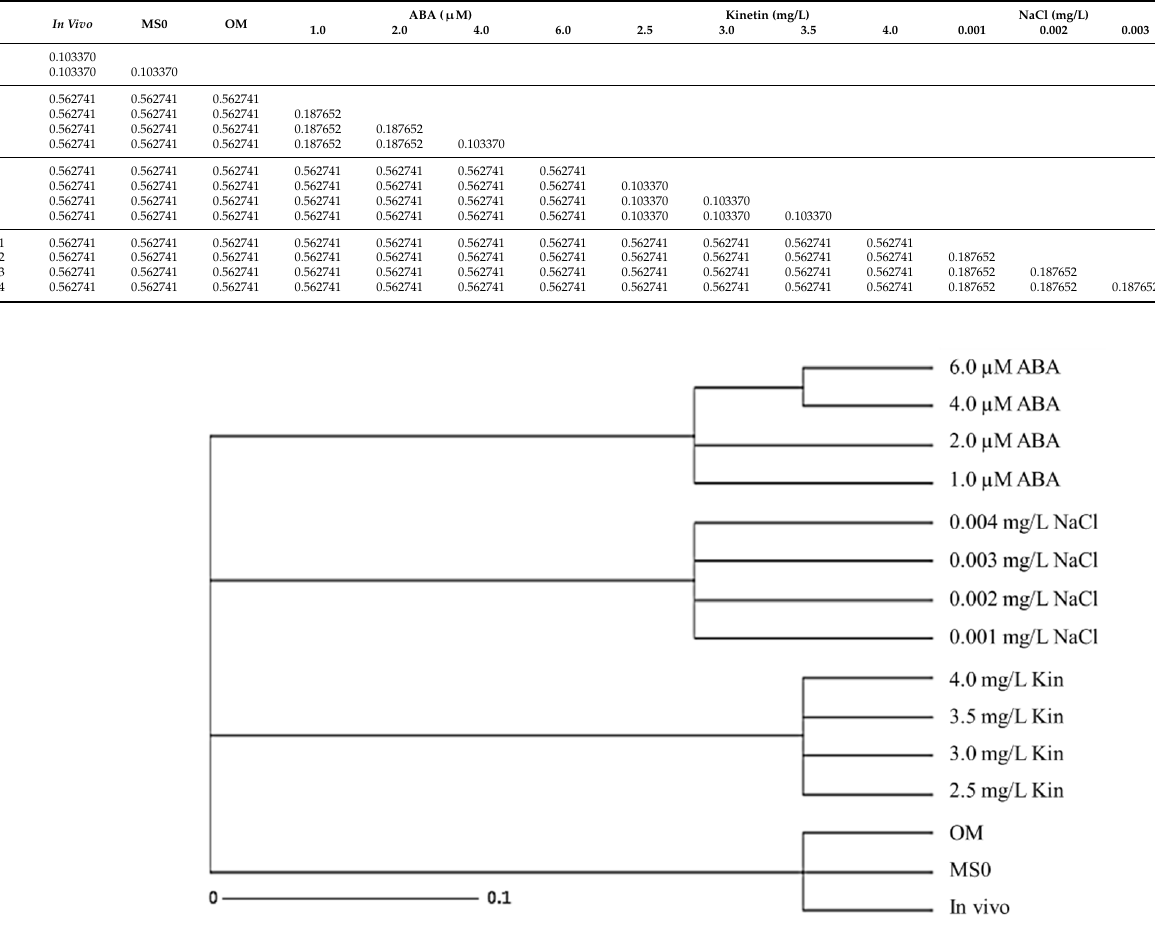
Figure 5. Phylogenetic tress constructed for plantlets exposed to various abiotic stresses as compared with the mother plant ( in vivo ), MS basal (MS0) and optimum media (OM).